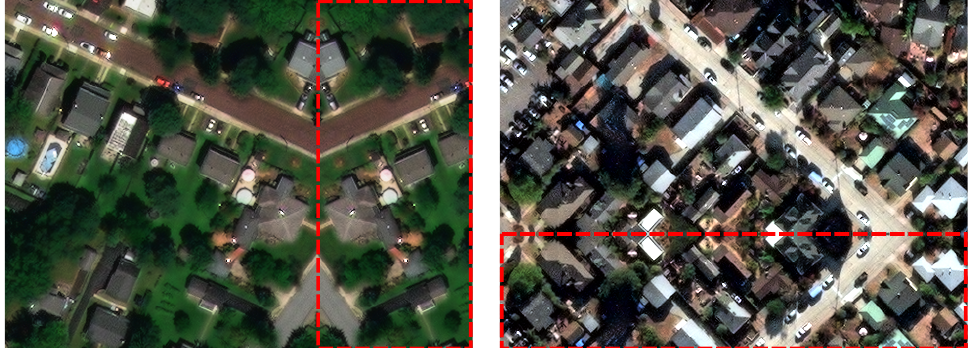
Figure 1. Symmetric auto-completion of patches: patches which partly fall outside the domain of the input image are filled with a mirrored version of the image content inside the patch. This avoids unwanted